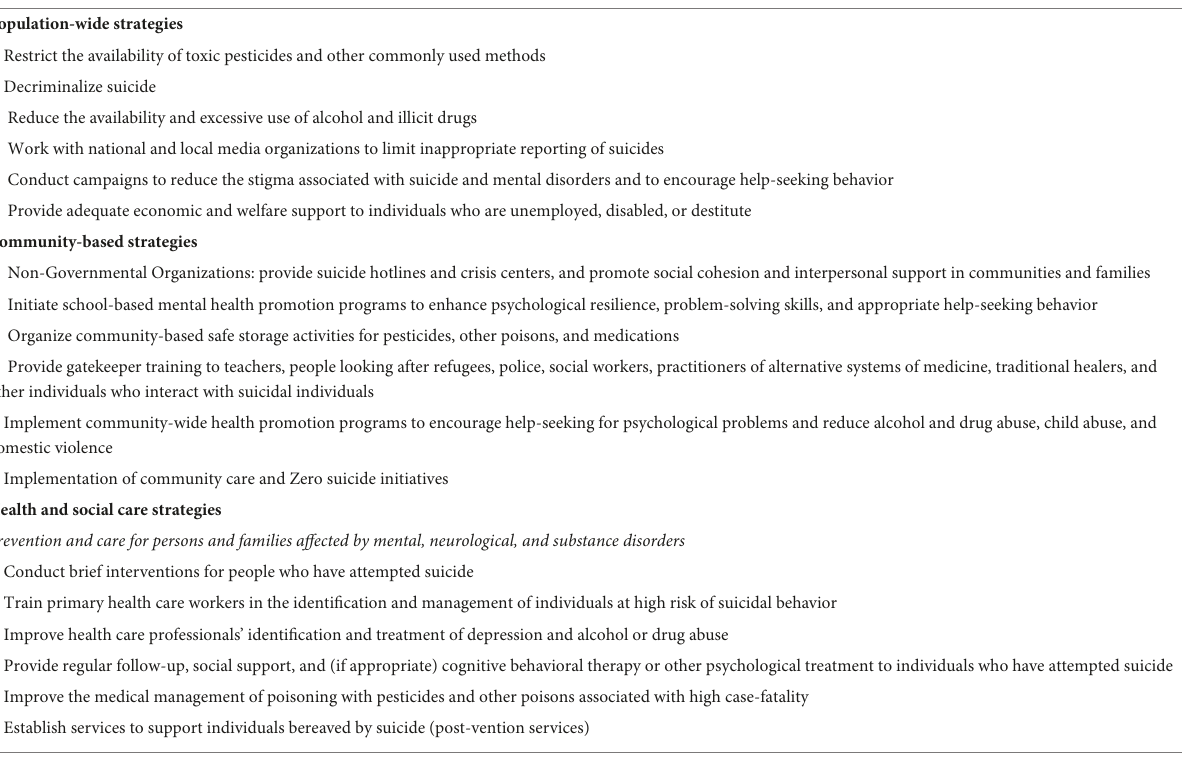
TABLE 1 Suicide prevention and intervention strategies in